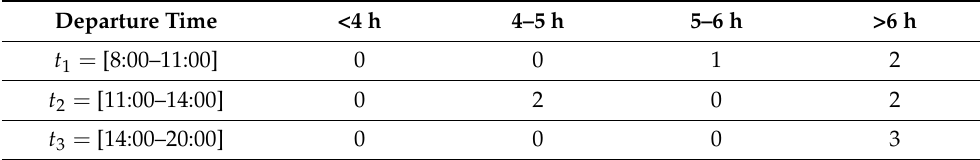
Table 7. Trains from Hangzhou to Xiamen on 1 April 2022.